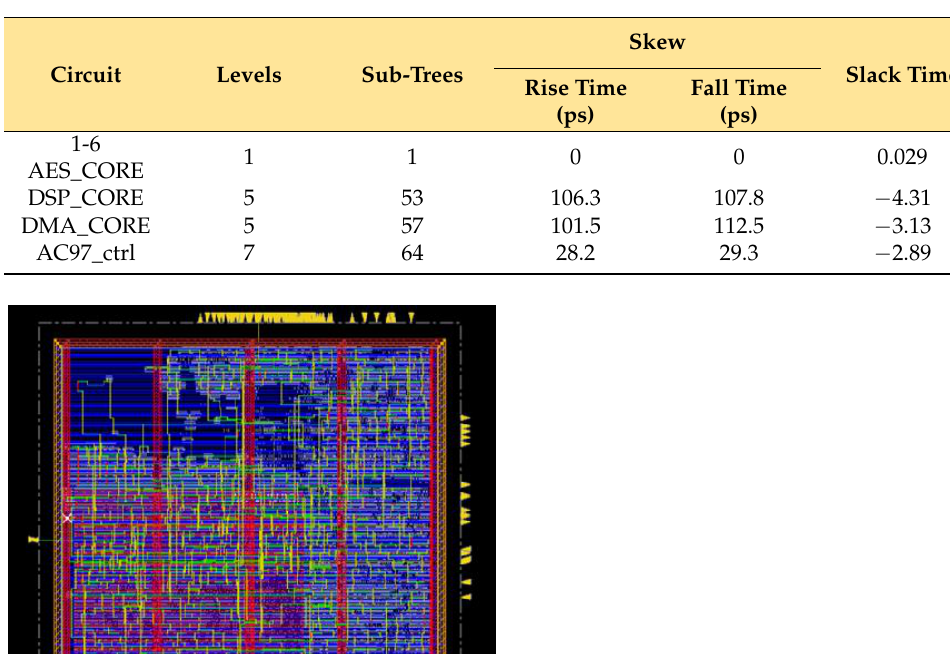
Table 6. Skew results using existing methodology.